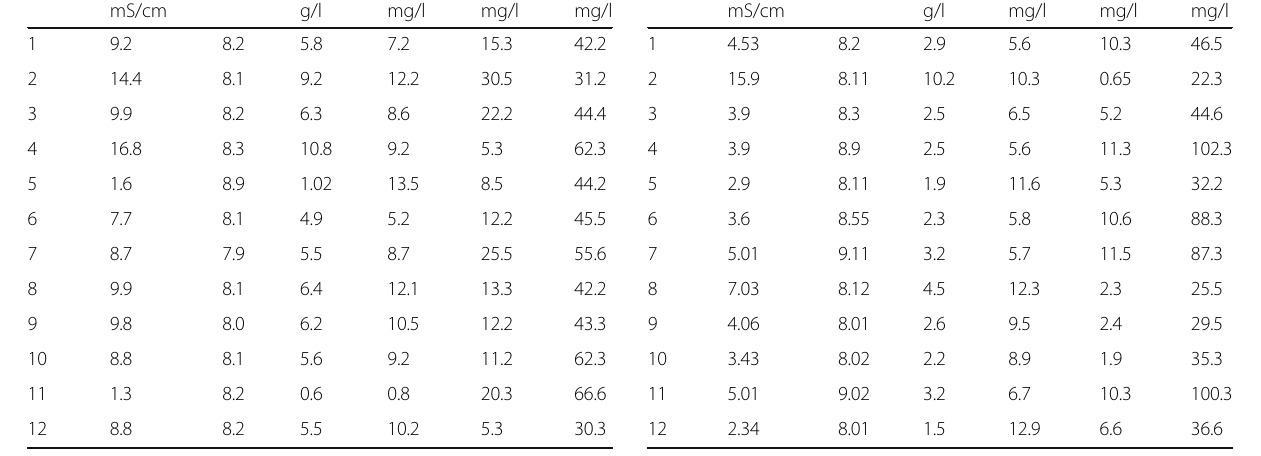
Table 5 Physicochemical parameters in surface water (During 2012)